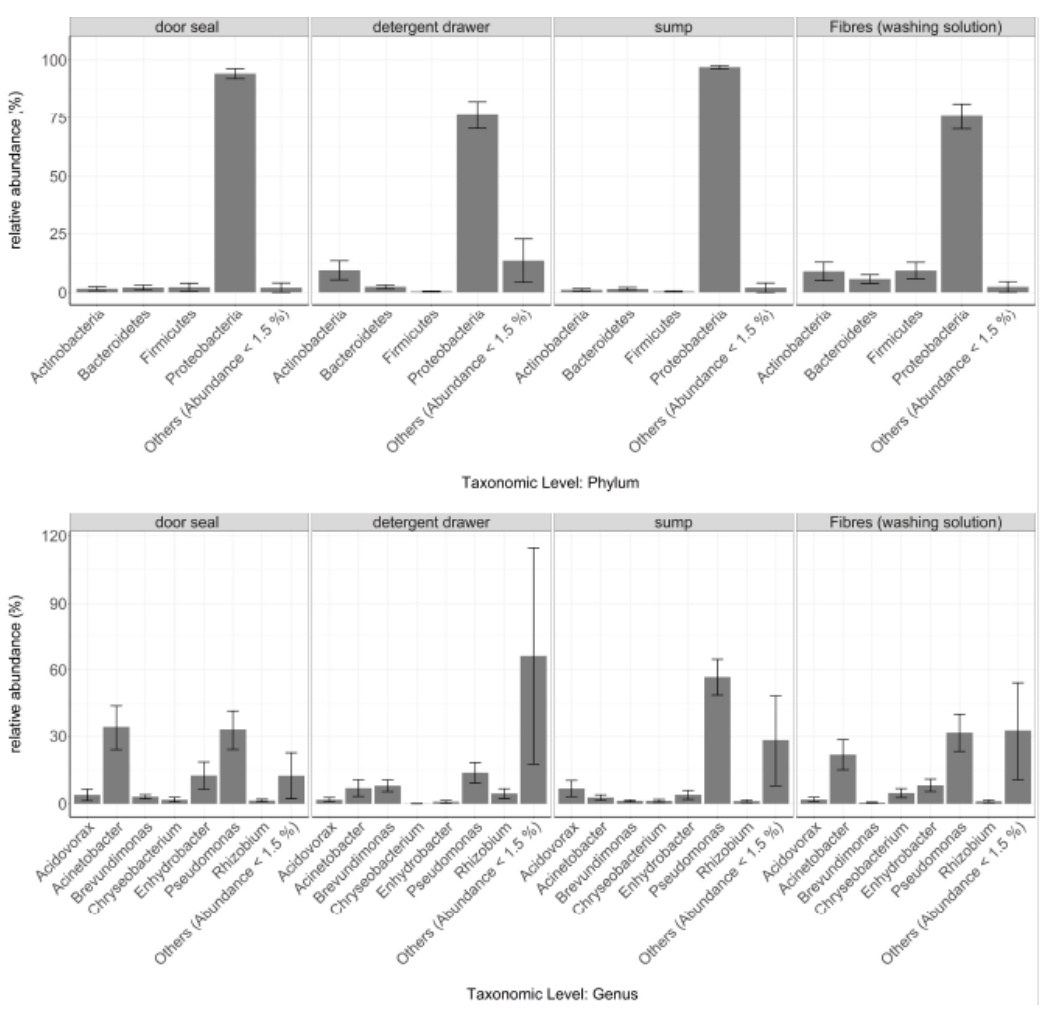
Figure 2. Relative abundances of the most abundant microbial phyla and genera at the different sampling sites. Only taxa with an overall relative abundance of ≥ 1.5% are shown Taxa with an overall relative abundance ≤ 1.5% were summed up as “Others”. Data are expressed as mean ± standard error (Door seal n = 13, Detergent drawer n = 13, Sump n = 12, Washing solution n = 12).